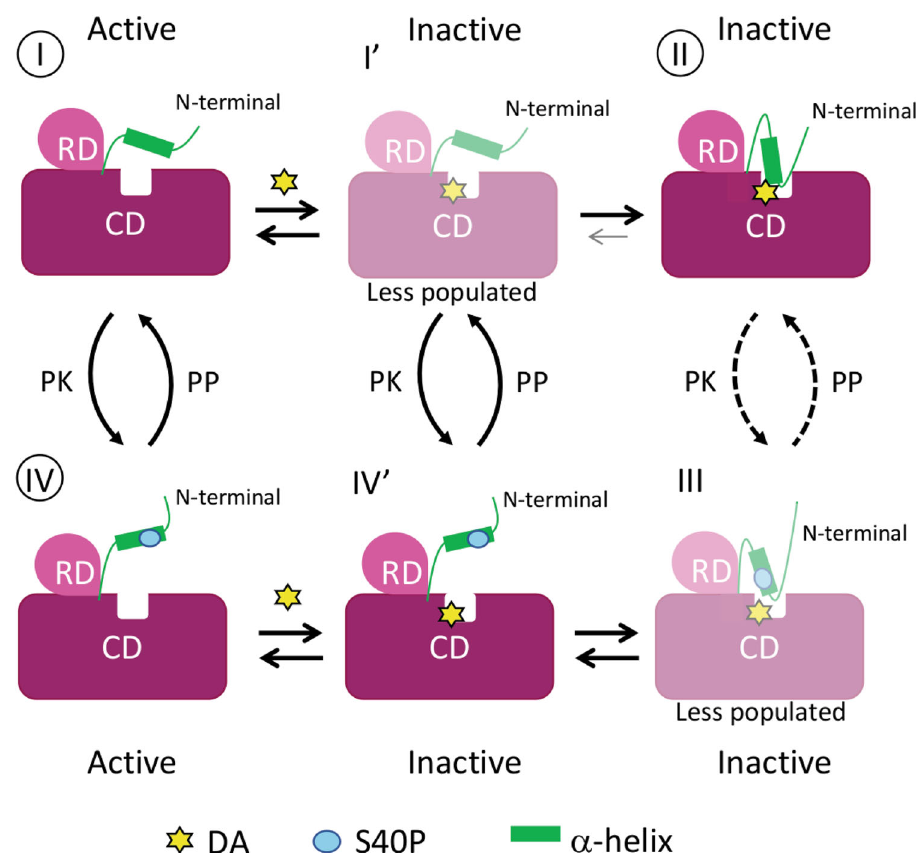
Fig. 7 Cartoon model of DA-mediated feedback inhibition of TH and its regulation by S40 phosphorylation. In the active, apo and non-phospho state, the 39 − 58 α -helix of TH is detached from the main structure (I, apo-TH). The feedback inhibitor DA binds to the TH active site, most likely in the open conformation (I ′ , TH(DA)). DA-binding favours interaction of the N-terminal α -helix with the same binding site, which blocks DA exit and contributes to the high-af fi nity binding and strong inhibition of TH activity (II, TH(DA)). Protein Kinase (PK) phosphorylation of S40 in TH(DA), leads to state III (THS40p(DA)), prompting the detachment of the α -helix from the TH active site (IV ′ ), which opens up for DA-dissociation and activation (IV, THS40p). PKs and protein phosphatase(s) (PP) control the transition between THS40p and unphosphorylated TH for both DA bound (I ′ ↔ IV ′ and II ↔ III) and apo- TH (I ↔ IV). States I ′ and III are expected to be only transiently populated during DA binding as state II and IV' will be more stable 21,51 (see main text). To indicate that our data do not support the presence of stable or well populated states I ′ and III, these are faded in the fi gure. S40 is also expected to be less accessible in state II than in state I (see main text), which is indicated by stippled lines for phosphorylation of TH in state II. The case for dephosphorylation is not known, but it could be expected that state III is a poorer substrate for PP than the open states IV ′ and IV. The dephosphorylation reaction III → II is therefore also stippled. The states where we provide structural details in this work (I, II and IV) are marked with